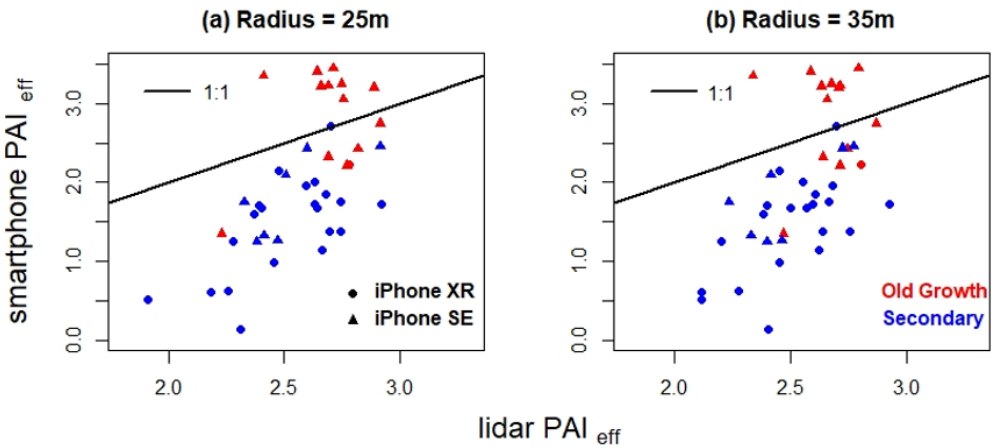
Figure 3. Relationship between smartphone and lidar PAI eff (using the four-ring smartphone PAI eff estimation method) assuming a spherical leaf angle distribution and using a radius of ( a ) 25 m and ( b ) 35 m in the lidar close points calculation.